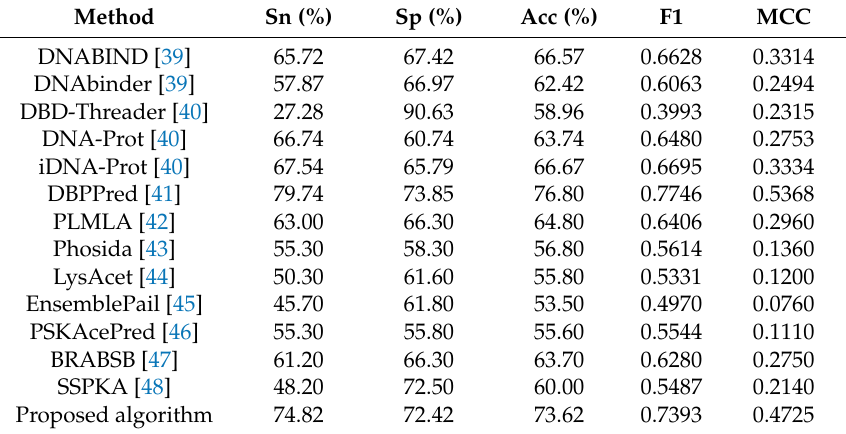
Table 6. Performances of different methods in H. sapiens